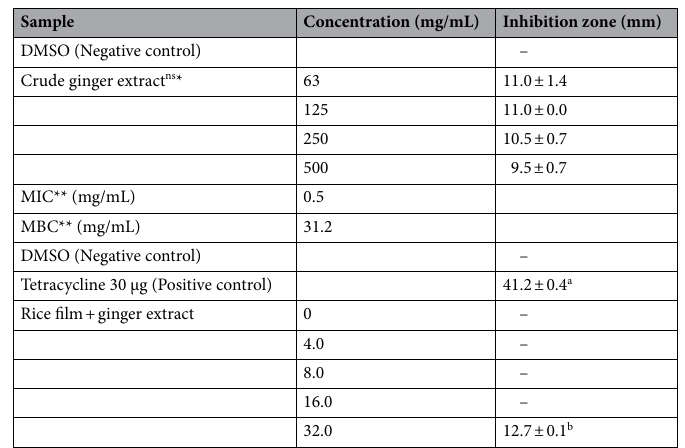
Table 4. Antimicrobial activity of crude ginger extracts and rice-based edible film at different concentrations against S. mutans by disc diffusion method. *ns means not significantly different at p ≤ 0.05. **MIC is Minimum inhibitory concentration; MBC is Minimum bactericidal concentration.